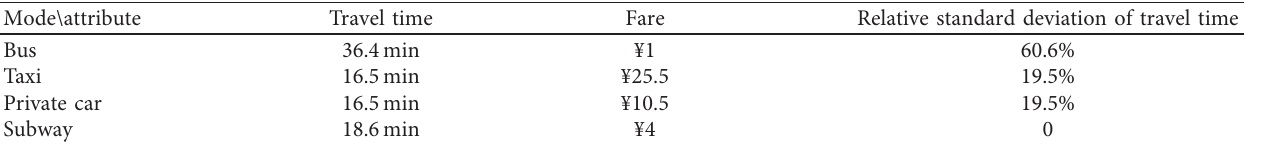
Table 5: Travel information of a long